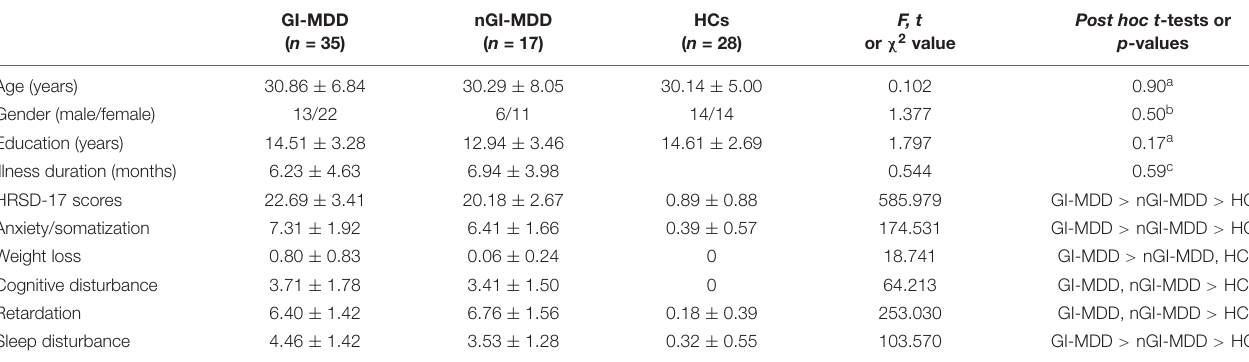
TABLE 1 | Demographic and clinical characteristics of the